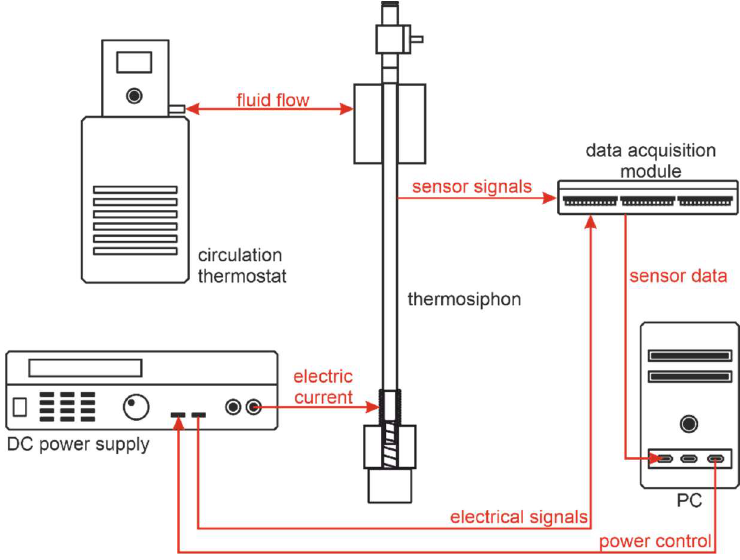
Figure 3. Experimental set-up.